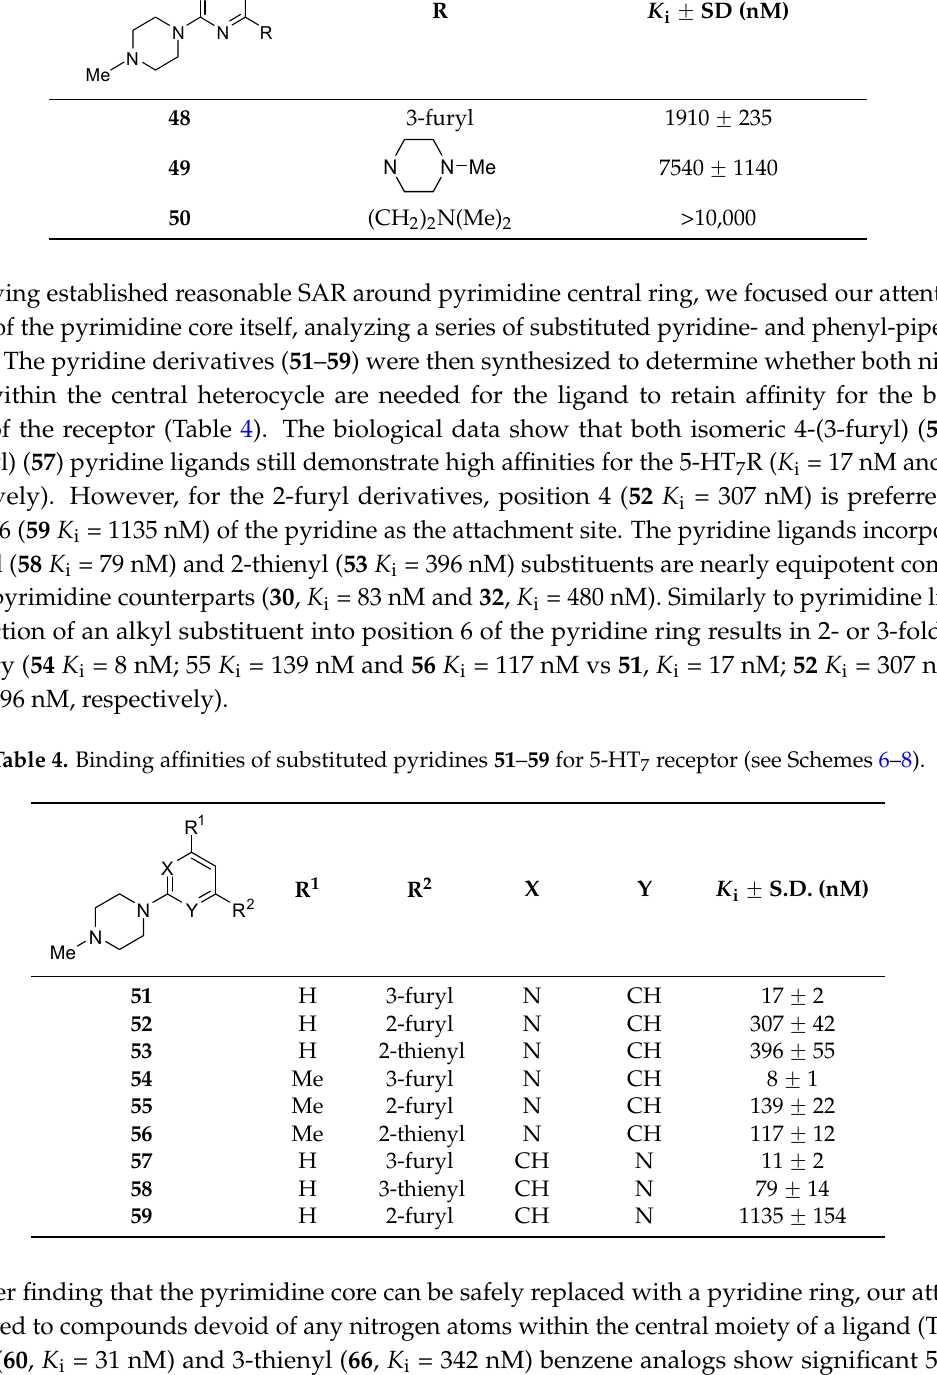
Table 5. Binding affinities of substituted benzenes 60 – 71 for 5-HT 7 receptor. R 1